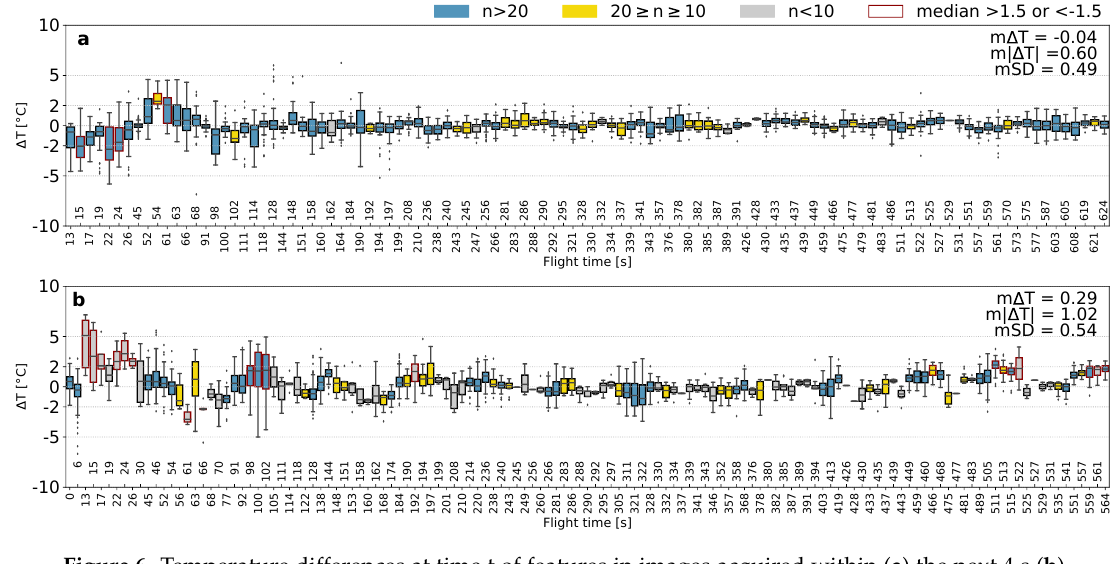
Figure 6. Temperature differences at time t of features in images acquired within ( a ) the next 4 s ( b ) minimum 50 s to paired features in image acquired at time t. n is the number of tiepoints. Please note the non-continuous and non-identical time